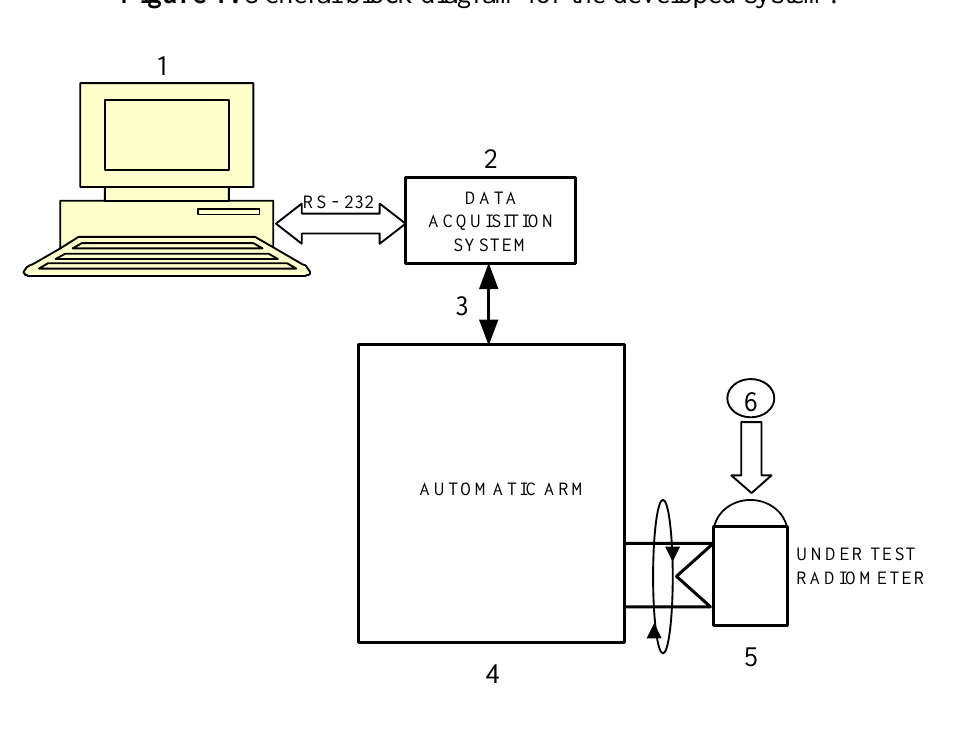
Figure 1. General block diagram for the developed